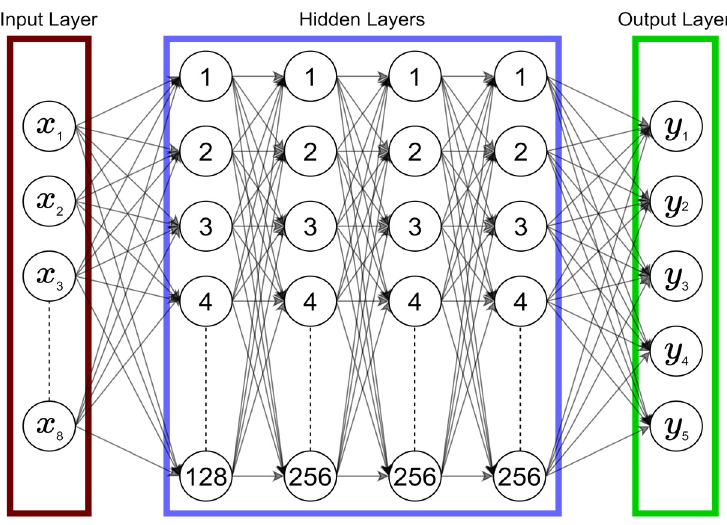
Figure 5. Representation of the architecture of the Y model.